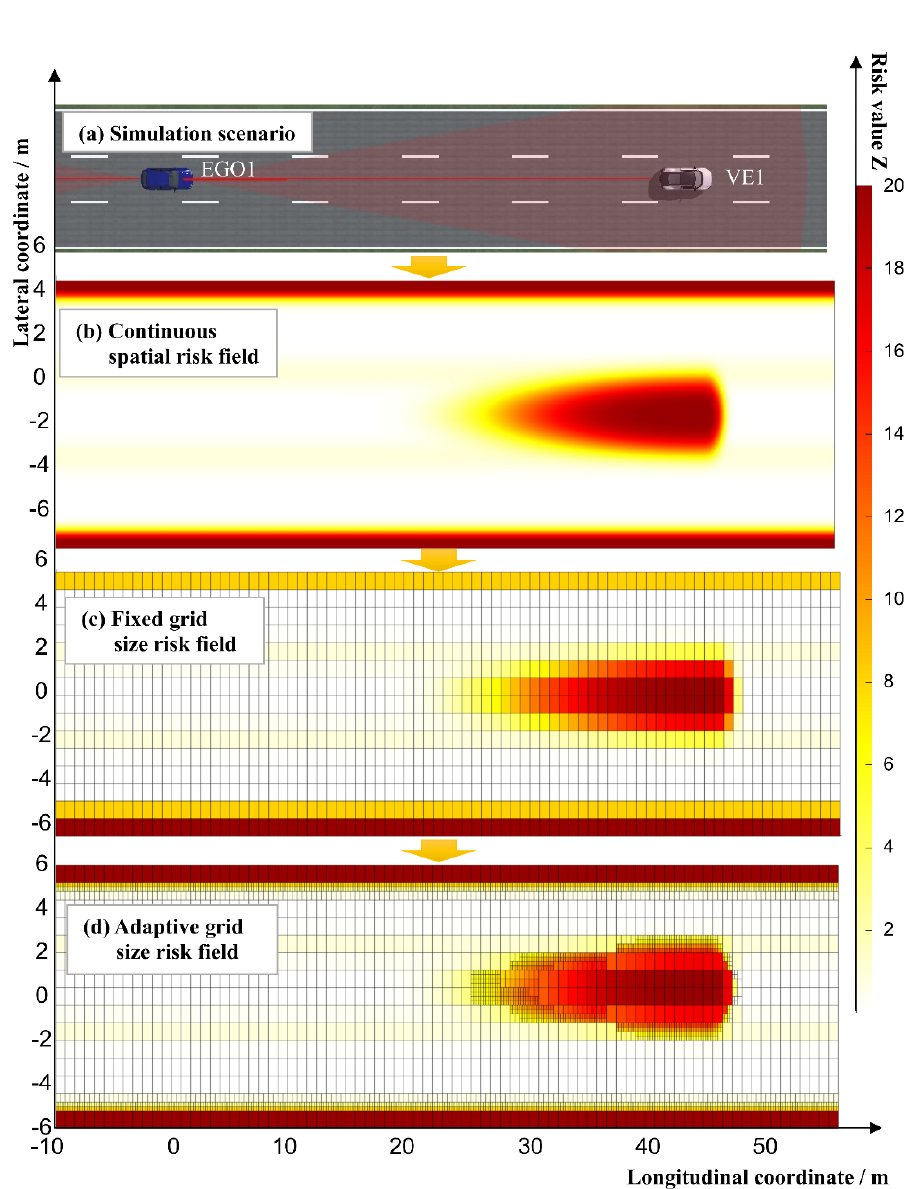
Figure 7. Adaptive grid risk-field generation for simulation scenario: ( a ) simulation scene diagram; ( b )continuous spatial risk-field; ( c ) fixed grid size risk field; ( d ) adaptive grid size risk field.